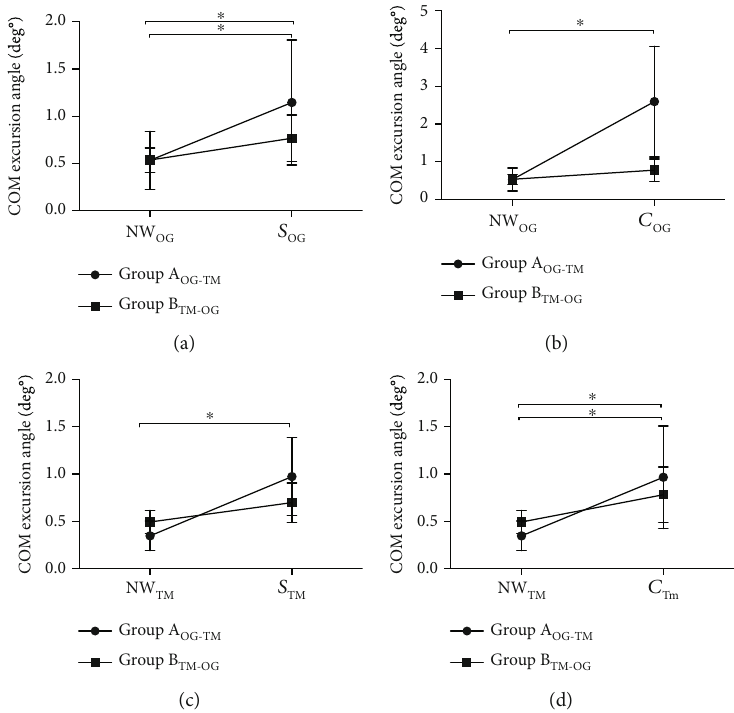
Figure 4: Comparative analysis of the COM excursion angle in response to the fi rst exposure to the VRE for both over-ground and treadmill surface conditions. (a) Mean and SD of the COM excursion angle for the fi rst natural walking (NW trial during over-ground walking. (b) Mean and SD of the COM excursion angle during the fi rst natural walking (NW crowded ( C ) VRE trial during over-ground walking. (c) Mean and SD of the COM excursion angle for the fi rst natural walking (NW OG ) VRE trial during treadmill walking. (d) Mean and SD of the COM excursion angle for the fi rst natural walking trial and the fi rst snowy ( S TM (NW ) trial and the fi rst crowded ( C ) VRE trial during treadmill walking. Signi fi cant changes between trials ( p < 0 : 05 ) are indicated by ∗ TM TM